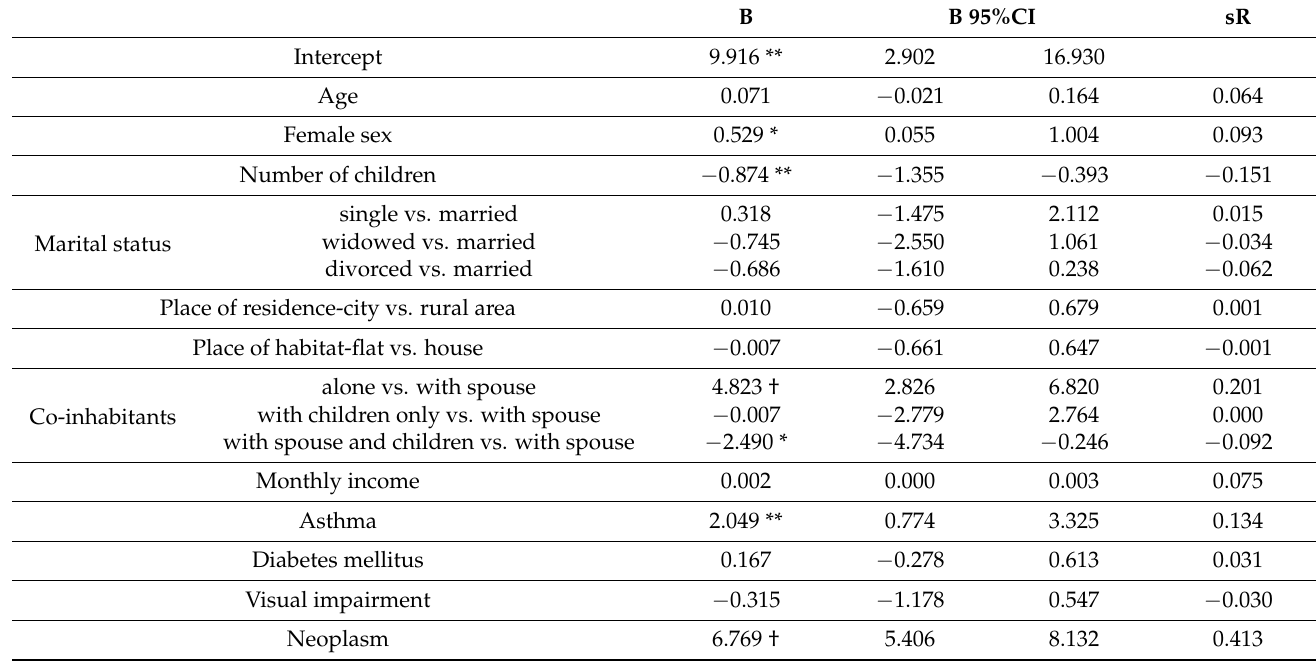
Table 3. Parameters of the linear regression model predicting the Beck Depression Inventory II score in the studied group of the older adults living in the city and in the rural